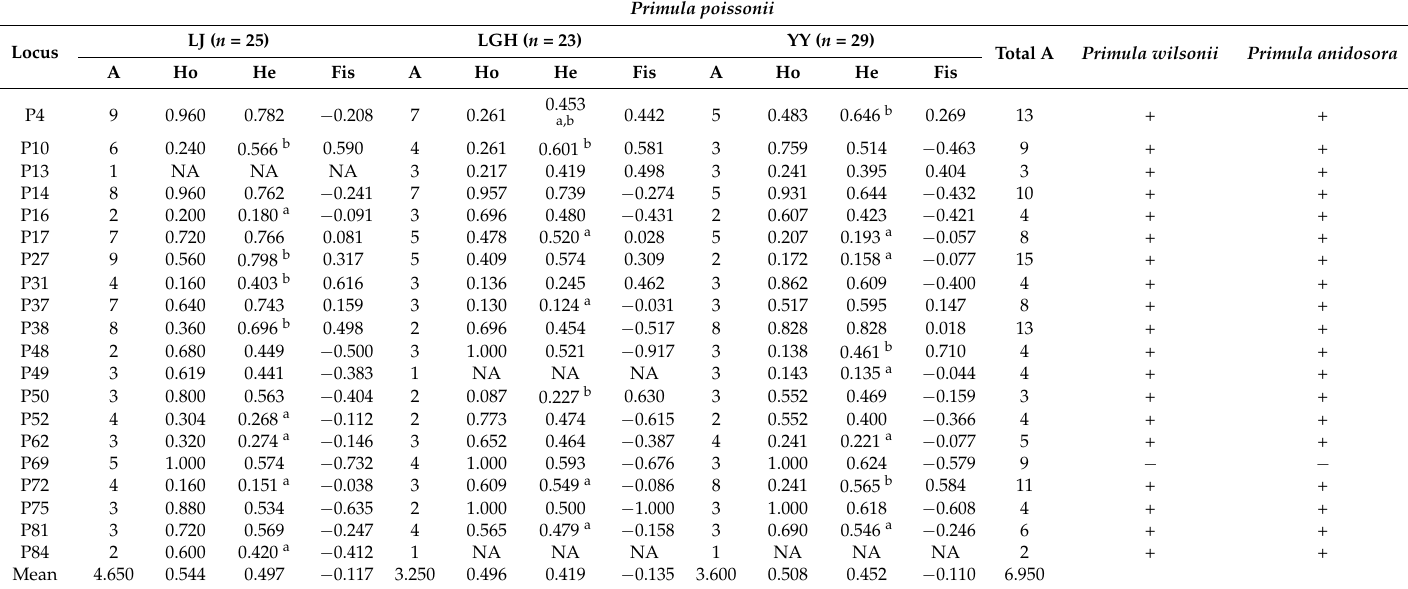
Table 2. Population genetic parameters estimated (per nSSR locus) in three populations and two species of Primula section Proliferae